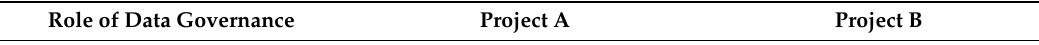
Table 4. Comparison of the cases with regards to the role of data governance in data science as a medium of human agency.